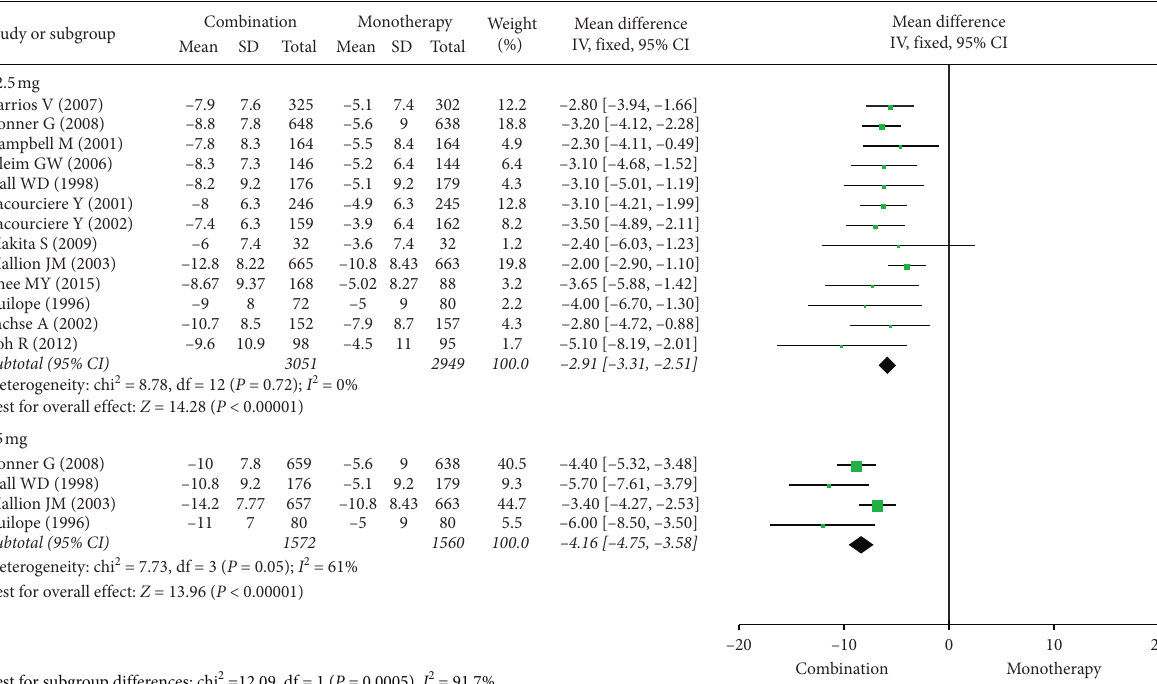
Figure 3: Forest plot for sitting diastolic blood pressure (SiDBP)